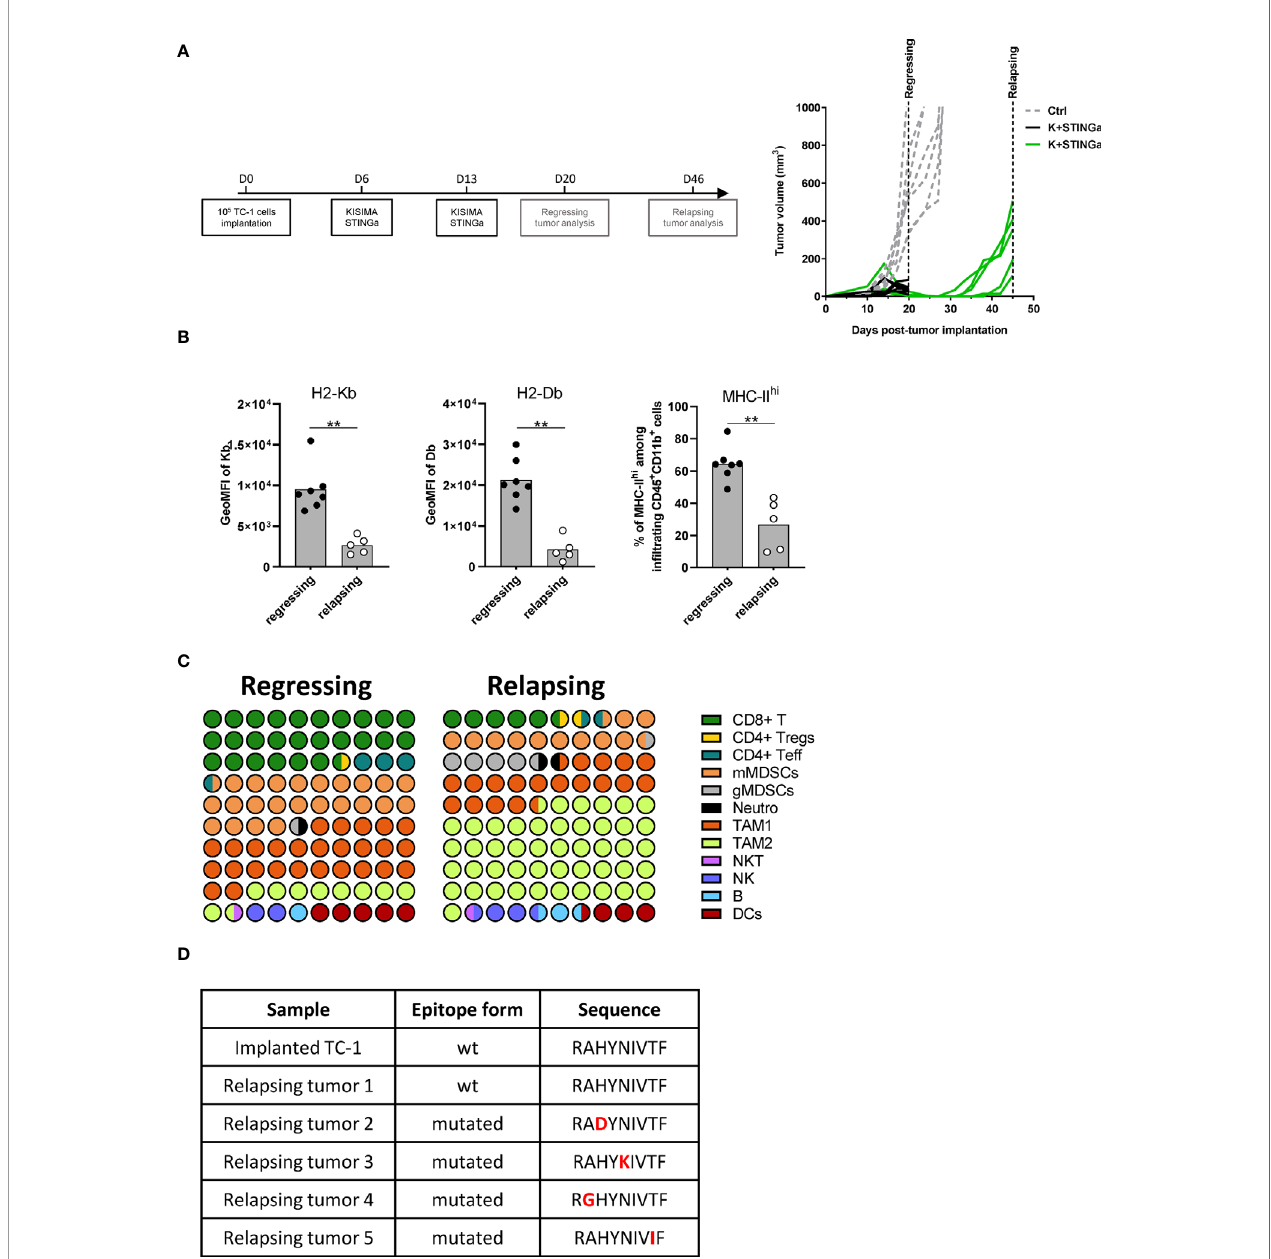
FIGURE 6 | Comparison of regressing and relapsing tumor microenvironment. 10 5 TC-1 cells were implanted on the back of C57BL/6 mice. When tumors were visible, mice were treated with two administrations of a combination of KISIMA vaccine and STING agonist at one-week interval. (A) Vaccination schedule and tumor growth. (B) Expression level of H2-Kb, H2-Db on CD45-tumor in fi ltrating cells and frequency of MHC-II hi among CD11b+ cells. (C) One (regressing) or four (relapsing) tumors. One (regressing) or four (relapsing) weeks post the last treatment, mice were sacri fi ced, tumor harvested, and tumor microenvironment was analyzed by FACS staining. Proportion of different cell populations among CD45+ tumor-in fi ltrating cells is shown; every circle represents 1% of the CD45+ population (see Figure S11 for gating strategy). (D) Sequence of HPV-E7 CD8 epitope expressed by implanted and relapsing tumors. (B – D) One representative of two experiments is shown (n ≥ 5/group/ replicate), Mann – Whitney test , **p <